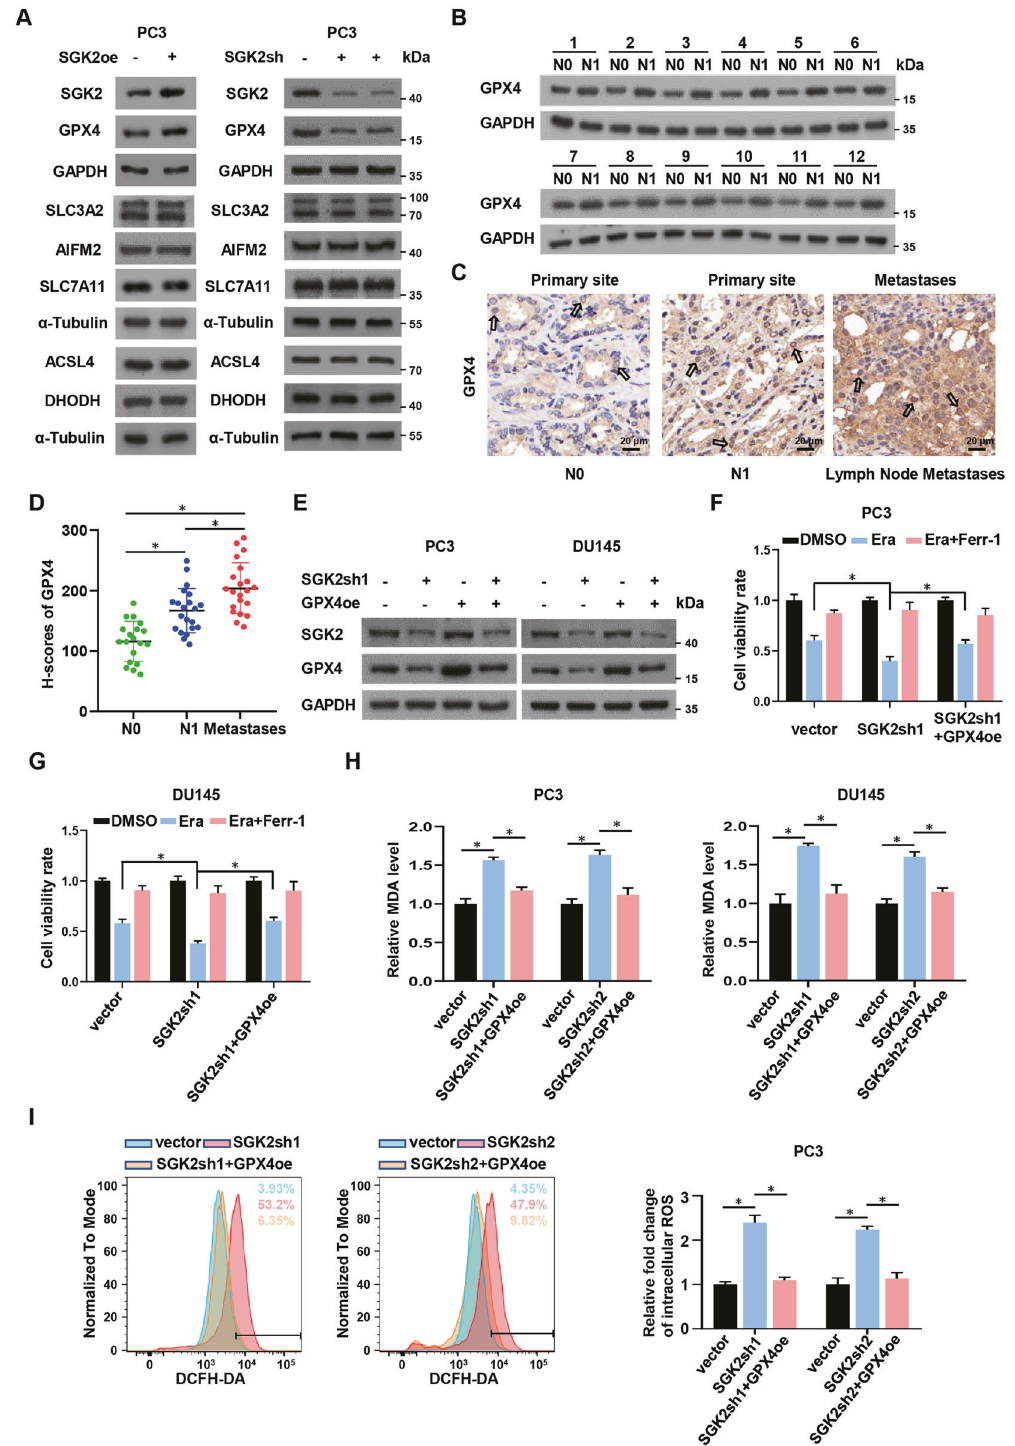
Fig. 3 SGK2 knockdown facilitates ferroptosis by downregulating GPX4. A Protein levels of ferroptosis-related genes were examined in SGK2 overexpressed or knockdown PC3 cells by western blotting. B Western blotting analysis of GPX4 expression in PCa tissues without lymph node metastasis(N0) and PCa tissues with lymph node metastasis(N1). C , D Immunohistochemistry (IHC) analysis of GPX4 expression difference and H-scores of GPX4 among PCa tissues without lymph node metastasis(N0) and PCa tissues with lymph node metastasis(N1) and corresponding Lymph Node Metastases tissues. Scale bars, 20 μ m. E Western blot assay showed the reversion ef fi ciency of overexpressed GPX4 after SGK2 knockdown in PCa. F , G Cell viability of PCa cells with SGK2 knockdown, with/without GPX4 overexpression, were measured after treating with Era (5 μ M), Era (5 μ M) and Ferr-1(5 μ M) for 24h by CCK-8 assay. H Concentrations of MDA were measured in the indicated group. I Intracellular ROS of the indicated group was stained by DCFH-DA and determined by fl ow cytometry. Data are presented as representative images or as the mean ± SD of three independent experiments. * P <